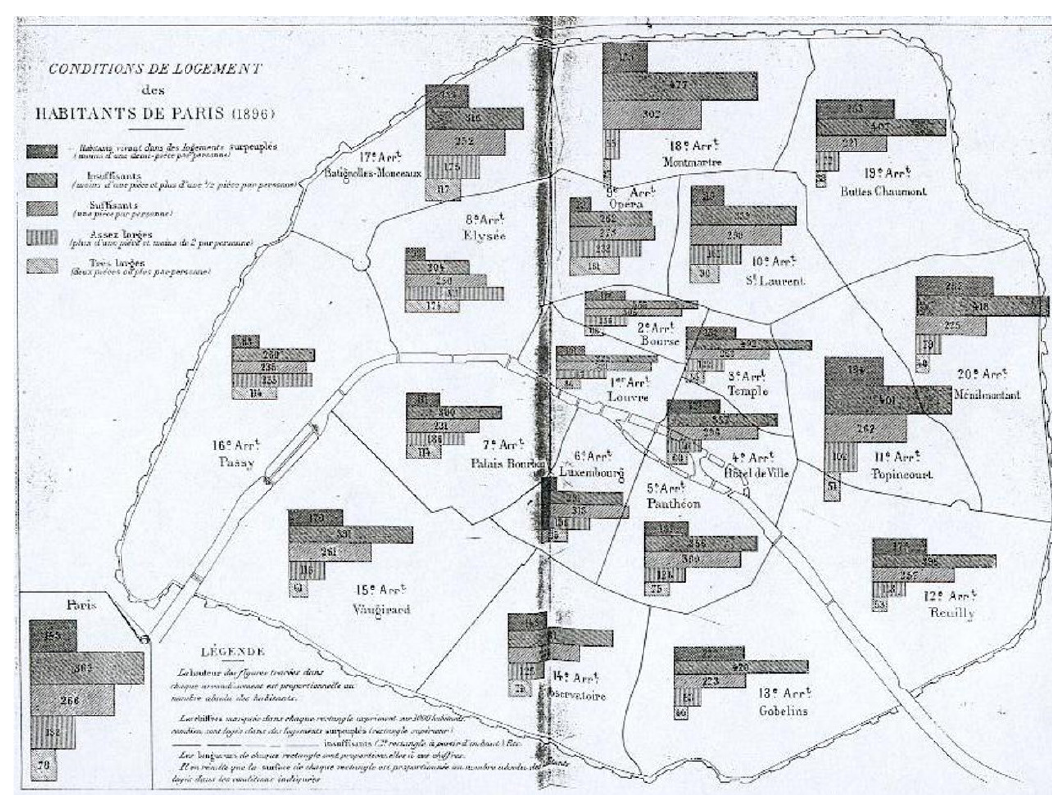
Figure 1. Housing conditions. Source: Bertillon (1894). parents and children alike, in the same room” (Bertillon, 1894, p. 9), he referred to the architectural prin‐ ciples of Haussmannian housing divided by “room,” “heated,” intended for the “conventional, large family,” and designed by architects trained at the Fine Arts School (École des Beaux‐Arts). This design was opposed to the working‐class way of living together in the same room in buildings built by